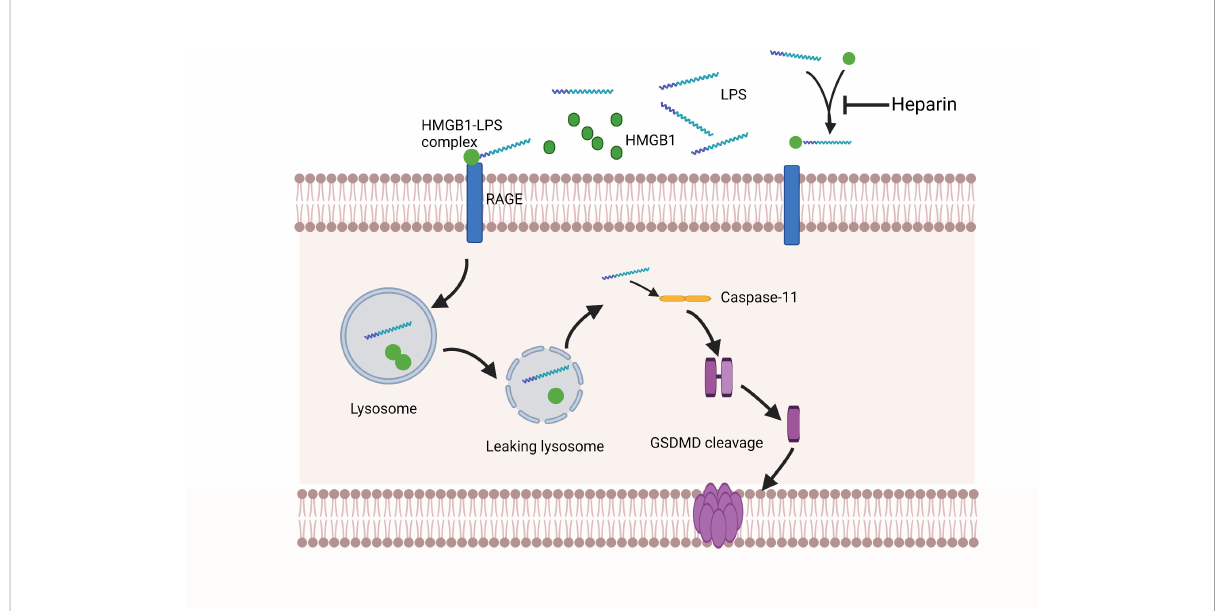
FIGURE 2 Extracellular HMGB1 and LPS form complexes. These complexes bind to the RAGE expressed by pulmonary endothelial cells, which is followed by the internalization of the HMGB1-LPS complex into lysosomes. Under acidic conditions, HMGB1 acts as a detergent to destroy the lysosome membrane, allowing LPS to enter the cytoplasm and activate caspase-11. Subsequently, activated caspase-11 mediates GSDMD lysis to form pores on the cell membrane, ultimately leading to pulmonary endothelial cell pyroptosis. Heparin has a high af fi nity for HMGB1, which can compete with the formation of HMGB1-LPS complexes and prevent pulmonary endothelial cell pyroptosis upstream of caspase-11